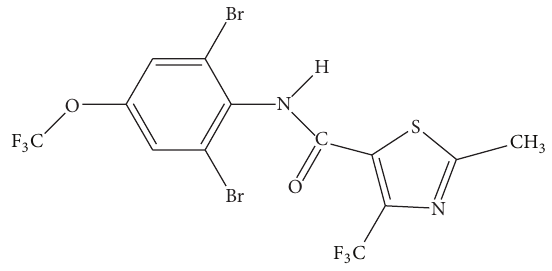
Figure 1: The chemical structure of thifluzamide.